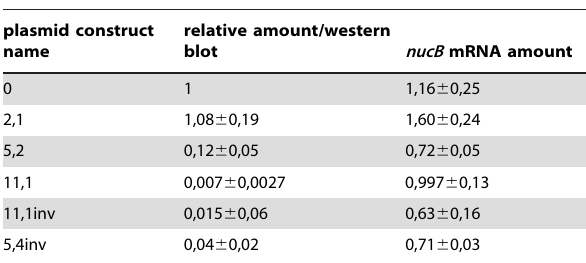
Table 3. Relative NucB protein level in P. bryantii TC1-1 cultures harboring pRH3 constructs containing start codon upstream sequences in which SD sequences form part of a secondary structures with different